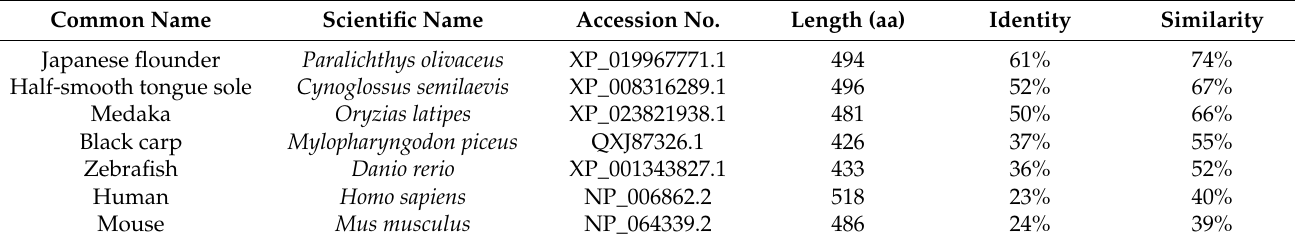
Table 1. Amino acid identity and similarity among Lc -RIP3 and RIP3 for other vertebrates.